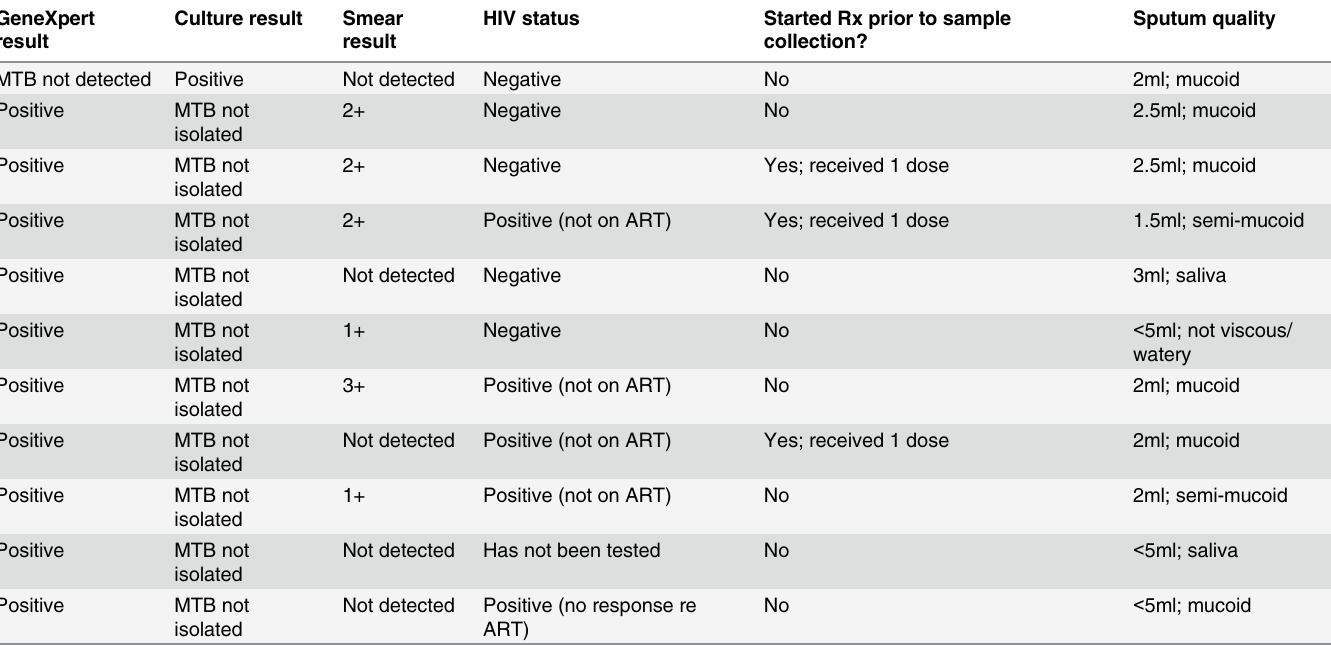
Table 3. Line listing of samples with discordance between GeneXpert and MGIT liquid culture for detection of TB. GeneXpert result